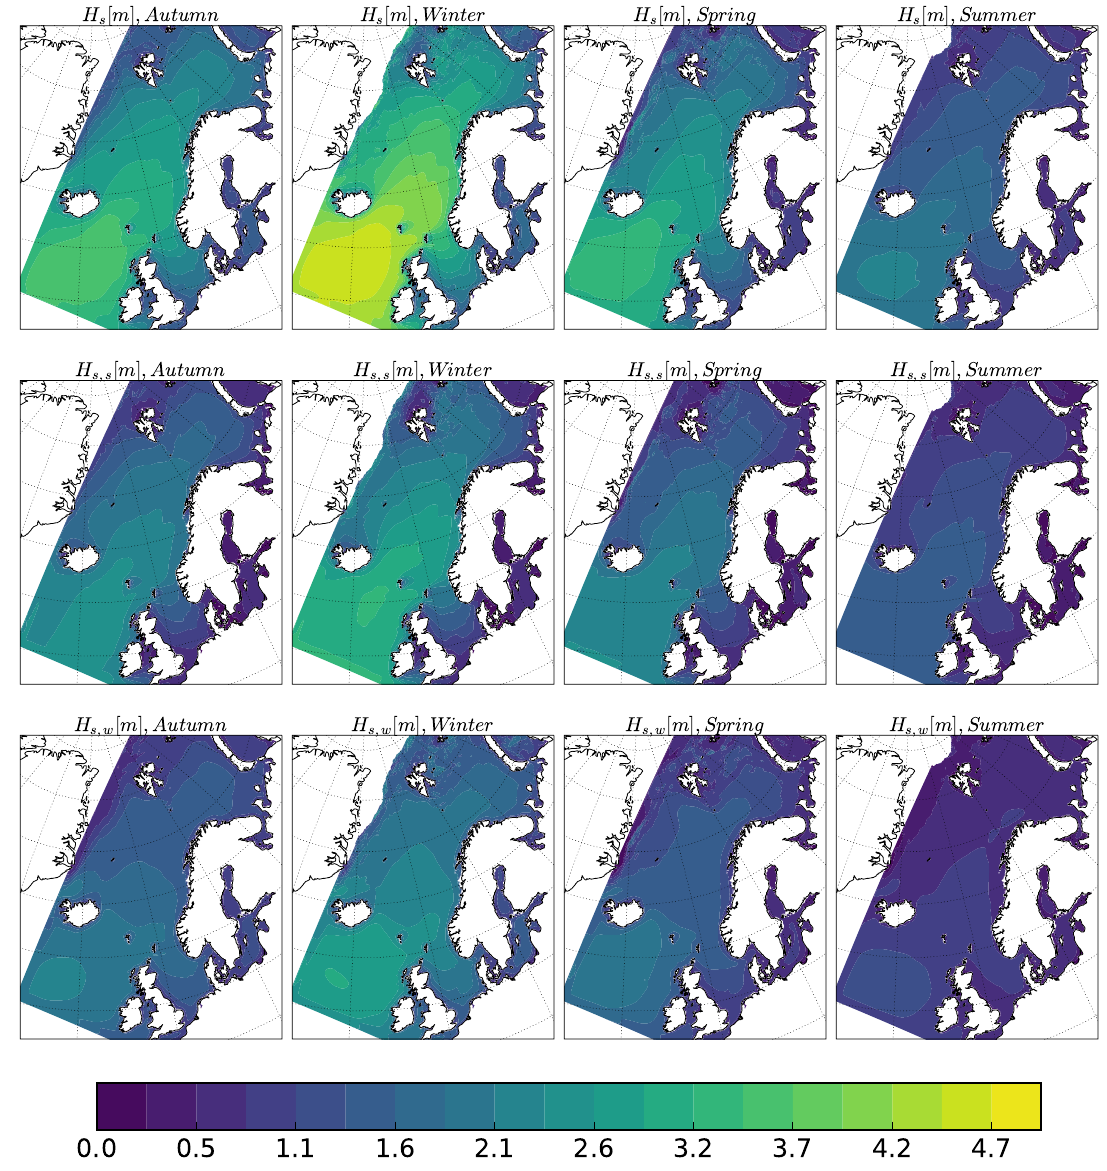
Figure 3. The average seasonal (autumn, winter, spring, and summer) H s , H s , s , and H s , w for the NORA10 domain for the period